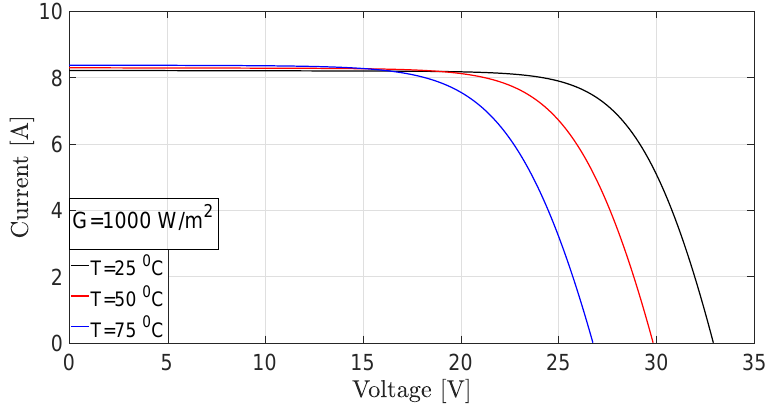
Figure 4. I–V characteristics of the PV source for various temperature values.